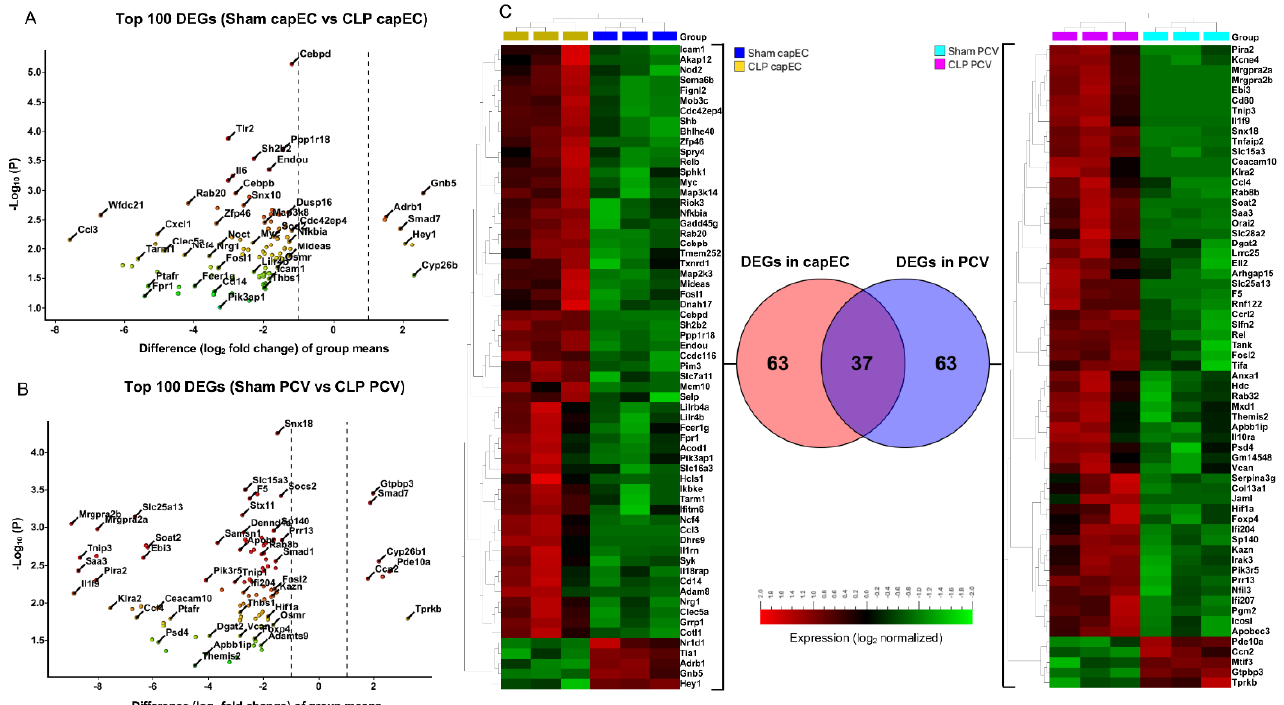
Figure 3. Top 100 differentially expressed genes (DEGs) in lung EC subsets. ( A ) Volcano plot showing top 100 DEGs in the capEC (sham capEC vs. CLP capEC), p ≤ 3.4 × 10 − 6 , padj ≤ 0.0004. ( B ) Volcano plot showing top 100 DEGs in the PCV (Sham PCV vs. CLP PCV), p ≤ 1.9 × 10 − 6 , q ≤ 0.0002. Volcano plot is constructed by plotting the negative log10 of the p value versus the group mean difference (log2 fold change). Variables are colored based on fold change, blue dots indicate upregulated in CLP and red dots indicate downregulated n CLP. Highly differed variables are in the top left and top right areas of the volcano plot. ( C ) Venn diagram showing overlapping of top 100 DEGs between capEC and PCV (middle panel), 84 different variables in capEC are shown in left heatmap and 84 different variables in PCV are shown in right heat map. Hierarchical clustering and box color of heat map are based on data normalization, mean = 0, variance = 1. p -value indicates statistical significance level and q-value indicates false discovery rate.